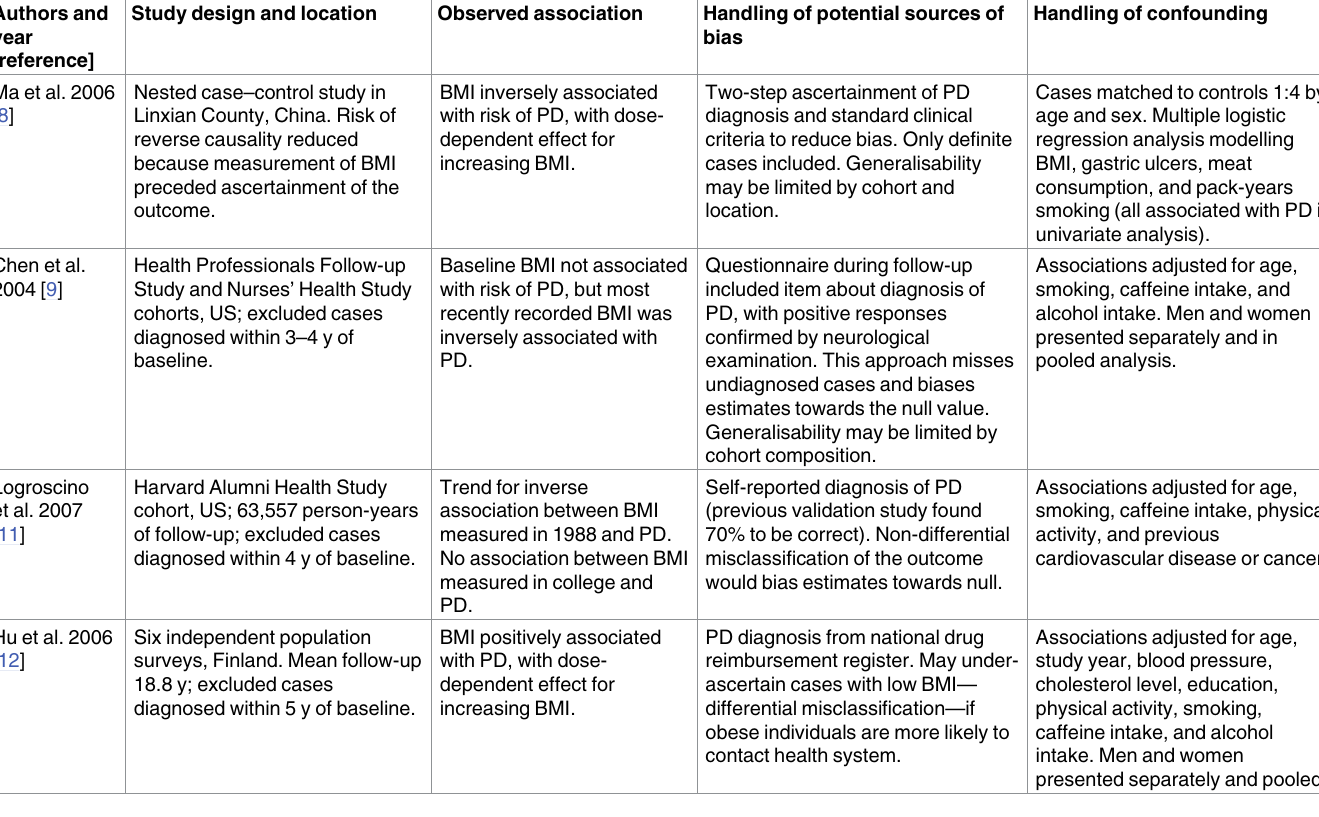
Table 2. Examples of previous observational studies of body mass index and Parkinson